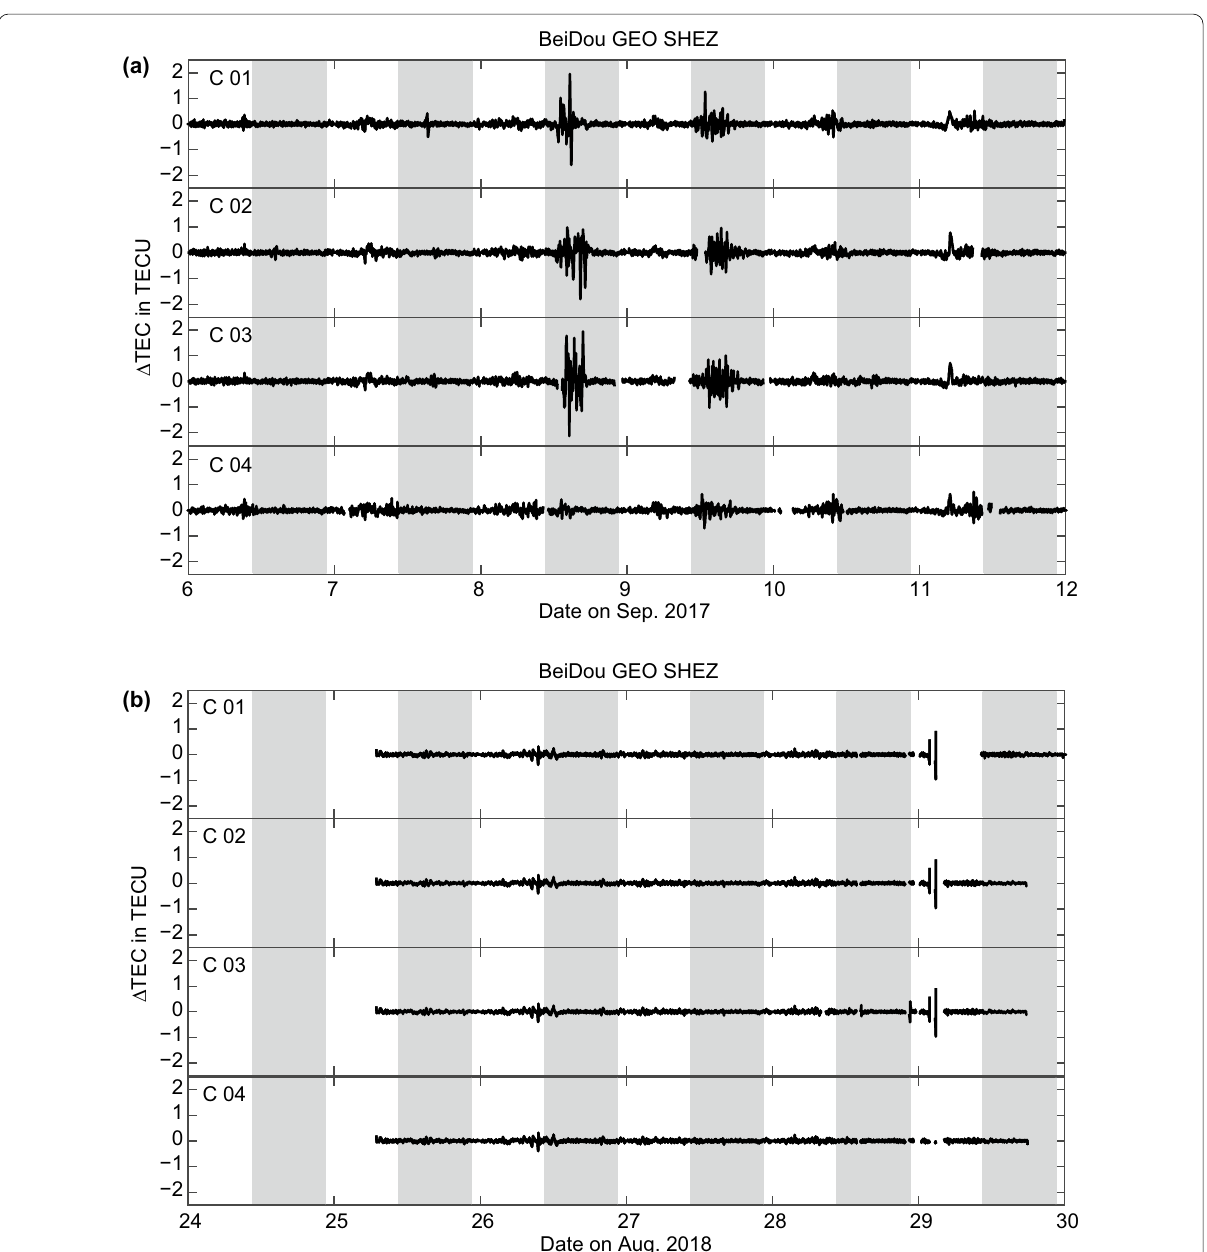
Fig. 6 As the same format as that in Fig. 5, but for showing the activity of small-scale TEC perturbations (less than 300